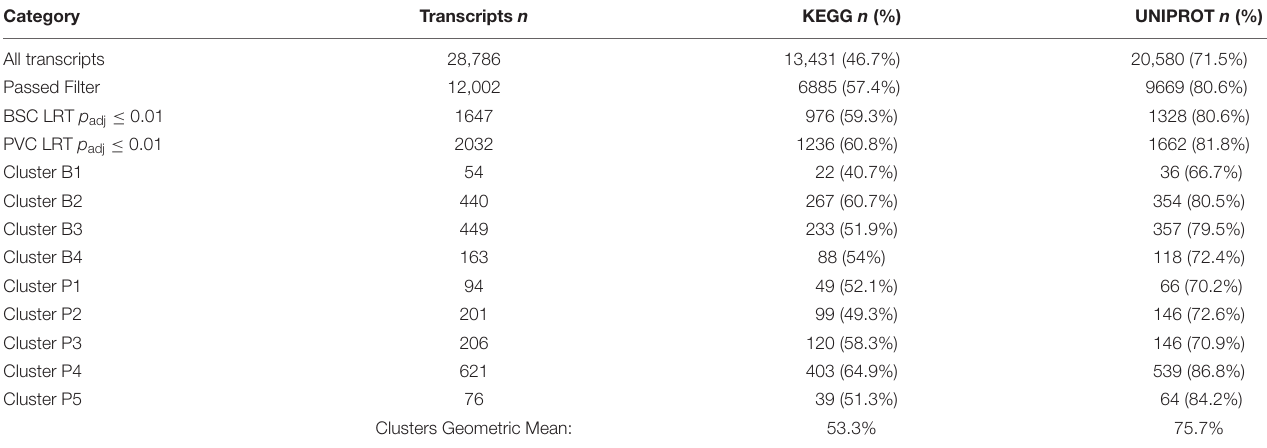
TABLE 2 | Transcript annotation